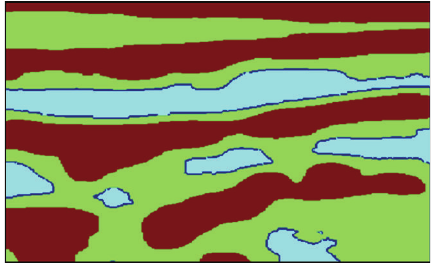
Figure 2: Segmentation by using 𝑘 -means, with 𝑘 = 3 .